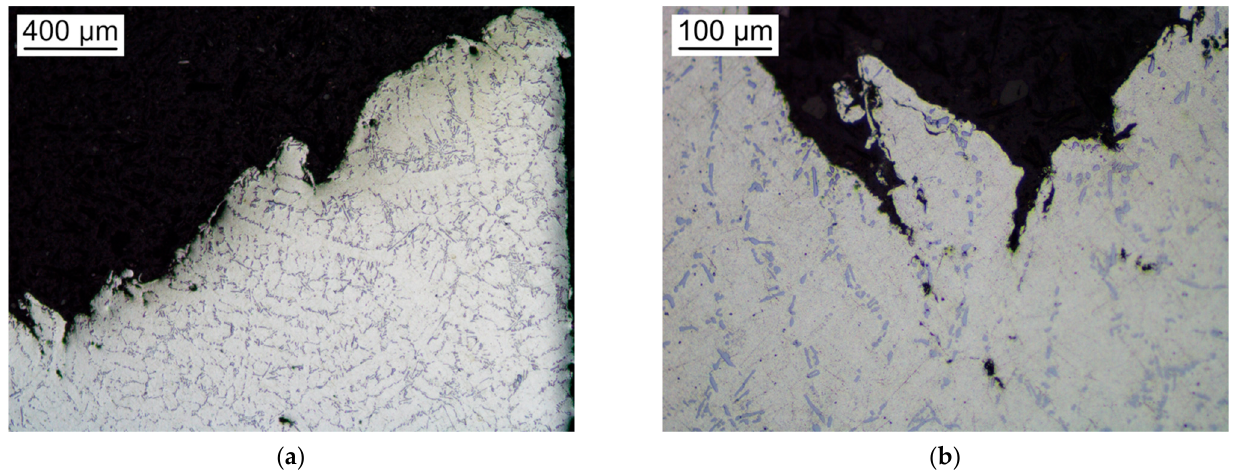
Figure 5. Optical micrographs of longitudinal sections of crept specimens A356 alloy at low ( a ) and high ( b ) magnification.